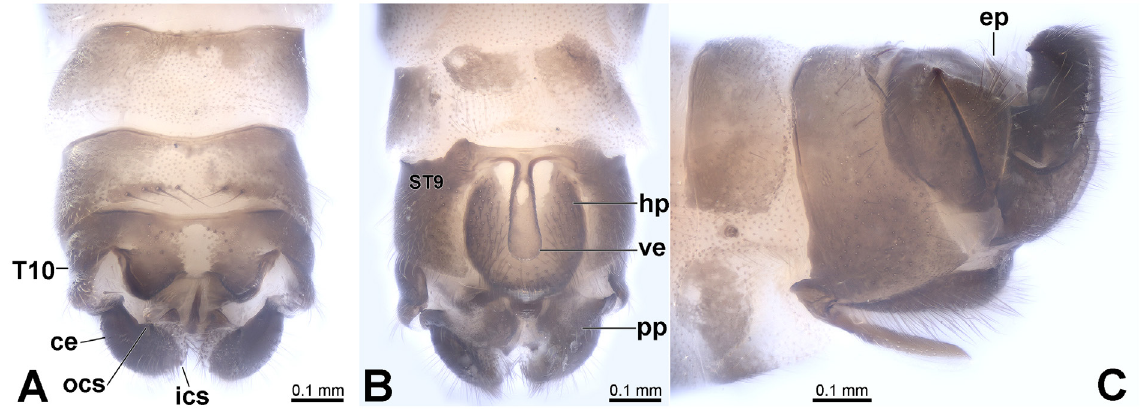
Fig. 3. Nemoura lixiana sp. nov. A . Male terminalia after NaOH treatment, dorsal view. B . Male terminalia after NaOH treatment, ventral view. C . Male terminalia after NaOH treatment, lateral view.